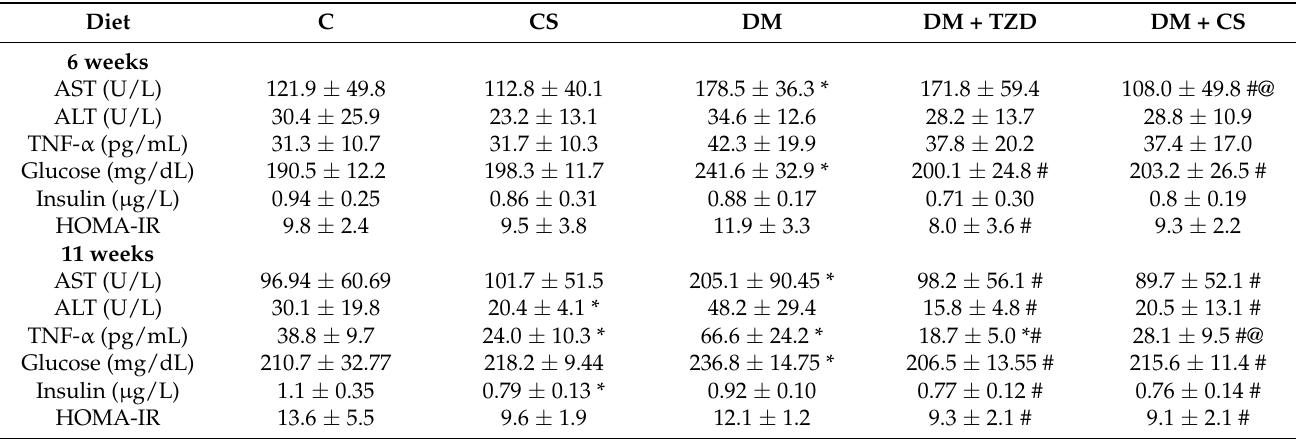
Table 3. The changes of plasma AST, ALT, Glucose, insulin concentration, and HOMA-IR index in SD rats fed different experimental diets for 6 and 11